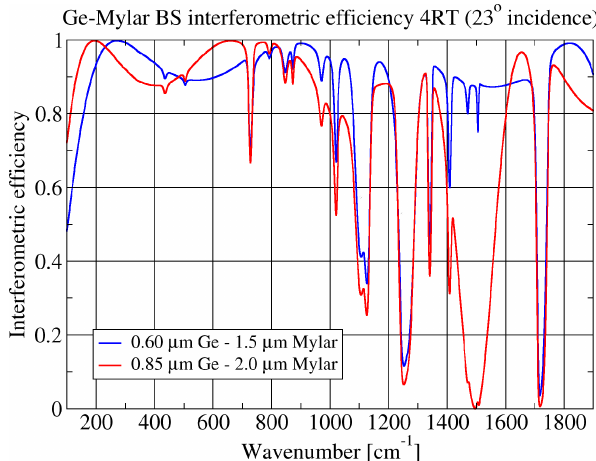
Figure 2. Real part of the interferometric efficiency (calculated as 4 times the product of reflectivity R and transmissivity T ) for two dif- ferent configurations of the bilayer germanium on Mylar substrate beam